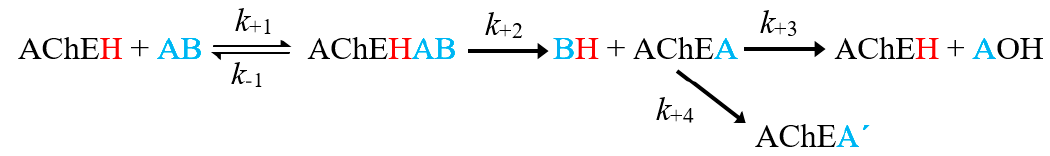
Figure 1. General scheme of the inhibition of acetylcholinesterase (AChE) by an organophosphorus (OP) inhibitor. Where AChEH is the free enzyme; AB, the OP molecule; AChEA’, the dealkylated form of the phosphorylated enzyme (AChEH) [14,15].